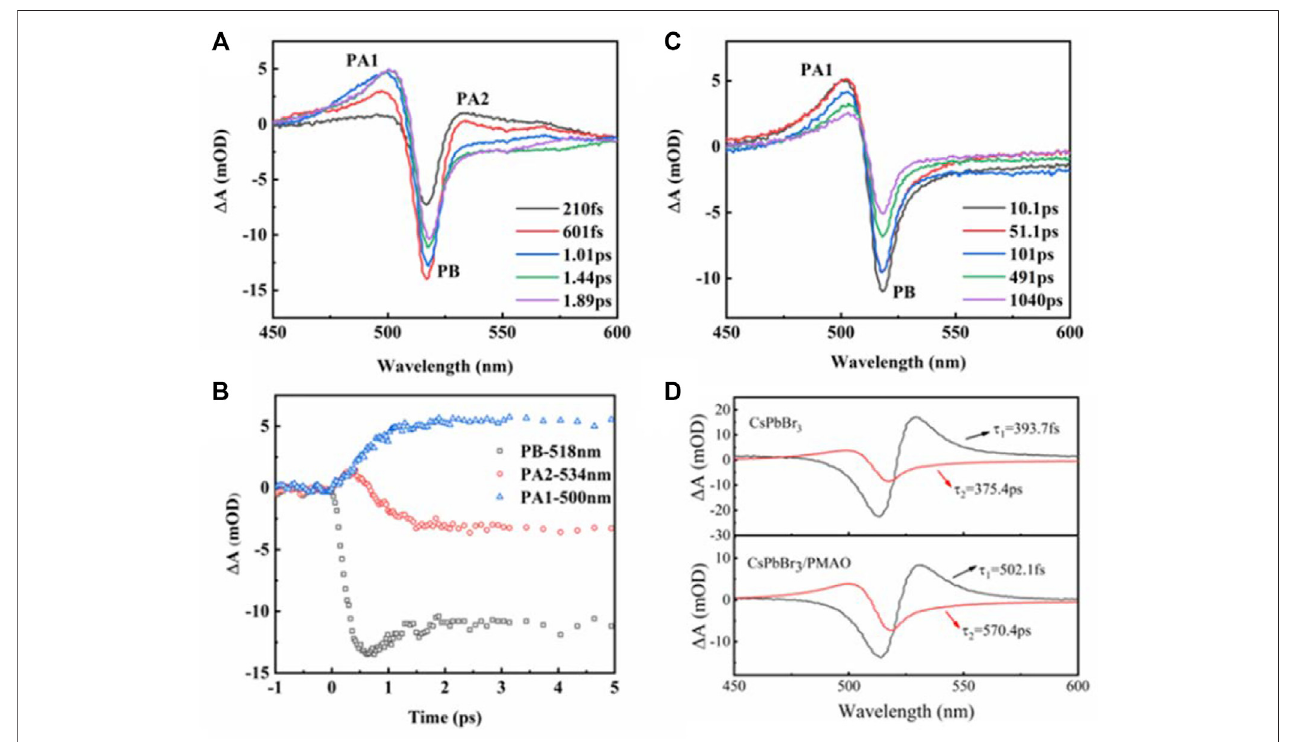
FIGURE 7 | (A – D) TA spectra of CsPbBr 3 /PMAO QDs (Xu et al.,